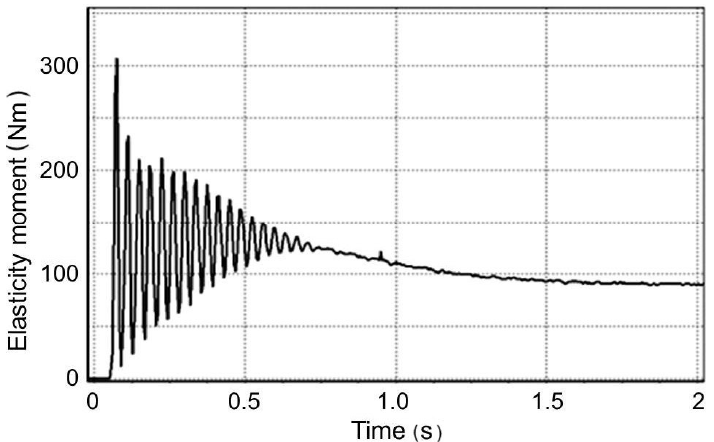
Figure 12. Measurement results of elasticity moment in a long-shaft drive transmission system.